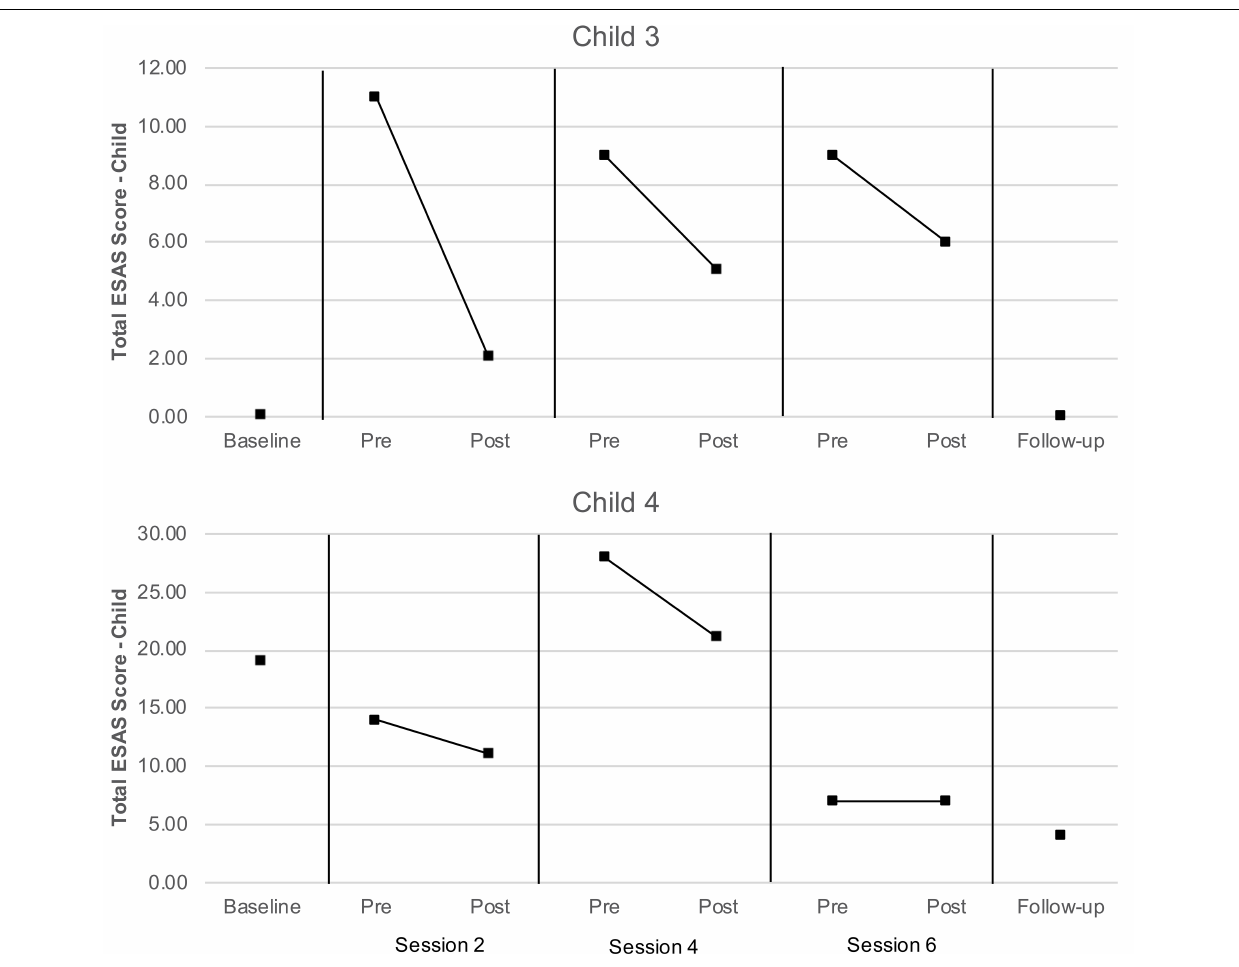
FIGURE 5 | Child ESAS scores (as reported by